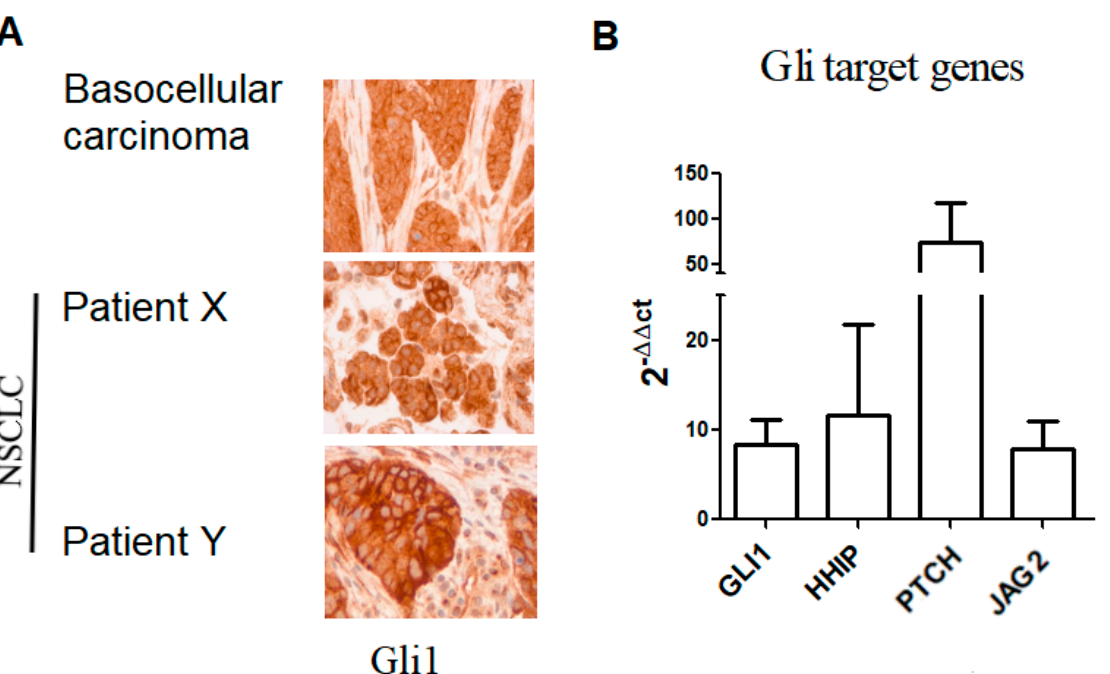
Figure 1. Hedgehog activation in NSCLC samples. ( A ) Immunohistochemistry analysis of Gli1 in NSCLC, patients X and Y are representative of Gli1+ patients (18/36). ( B ) mRNA expression of Gli1 target genes in NSCLC, data are expressed as mean ± SEM of 12 patients analyzed in duplicate. Two lung tissue samples not expressing Gli1 as assessed by IHC were used as reference samples or calibrators. A sample from basocellular carcinoma were used as positive control both for the IHC and the RT-qPCR. NSCLC: non-small-cell lung cancer.